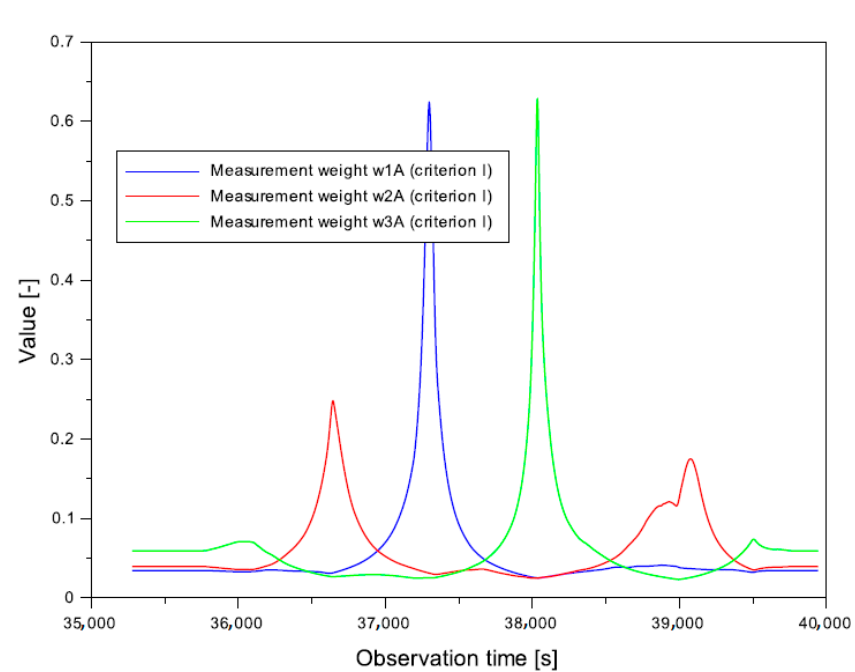
Figure 18. The measurement weights for criterion I.